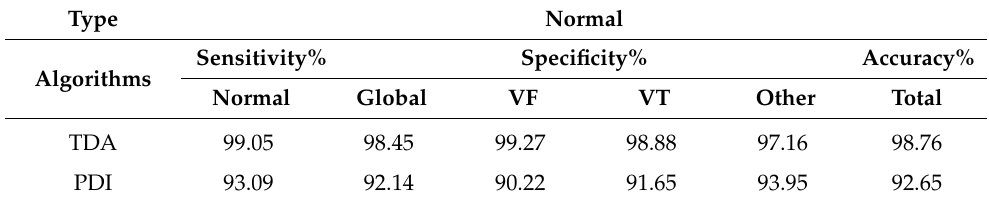
Table 9. Results obtained for Other class classification in testing. Type Other Sensitivity% Algorithms